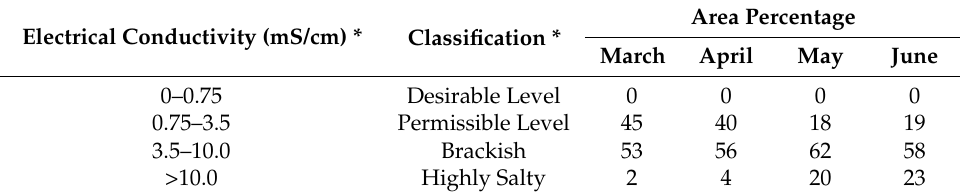
Table 1. Classification of drinking water quality (based on Sri Lankan Standards).